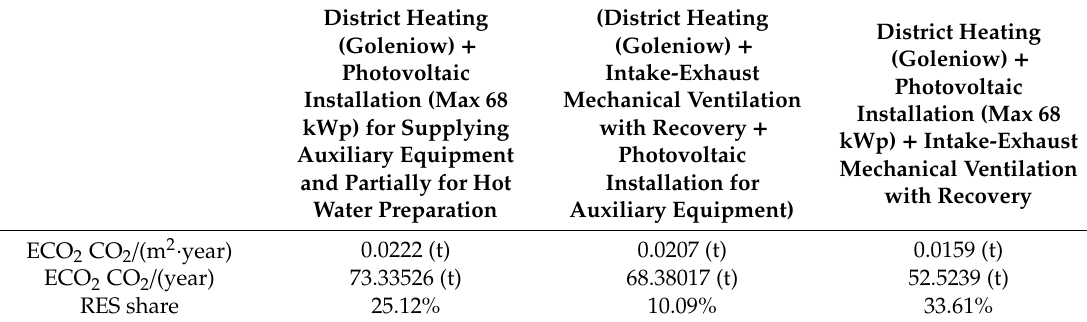
Table 26. The annual CO 2 emissions depending on the accepted heat source for the multi-family building at Akacjowa Street in Goleniow.